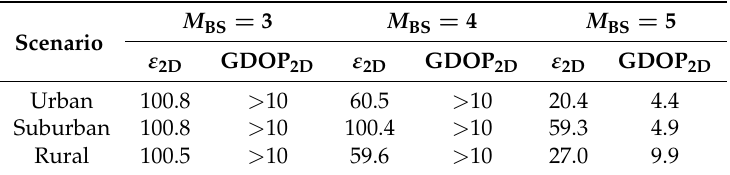
Table 3. 2D position error (in meters) and GDOP on the 95% of the cases with stand-alone cmWave ToA positioning as function of the number of BSs.